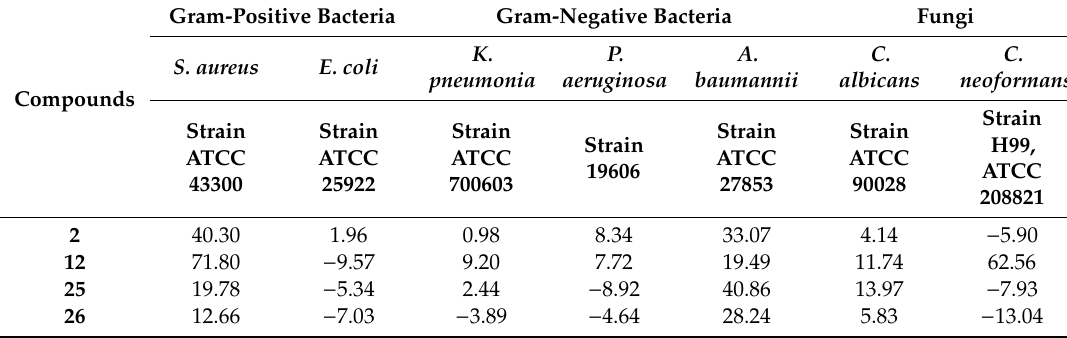
Table 7. % Growth inhibition of compound 2 , 12 , 25 and 26 at concentration 32 µ g / mL.